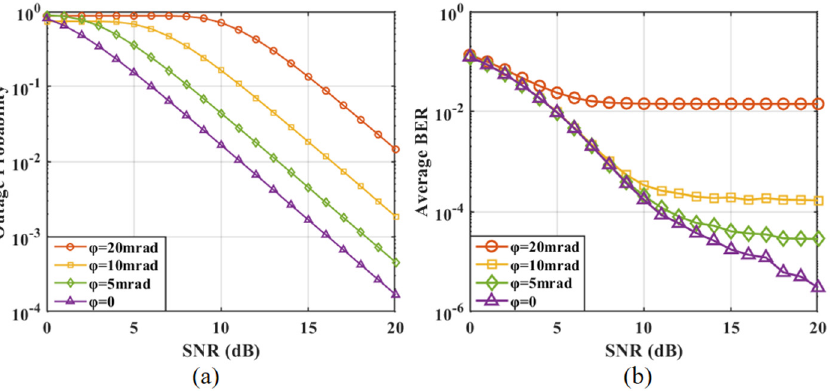
Figure 5. FSO communication performance of UAVs at different tilt angles when the UAV flies straightly at the same altitude. ( a ) Outage probability; ( b ) average BER.